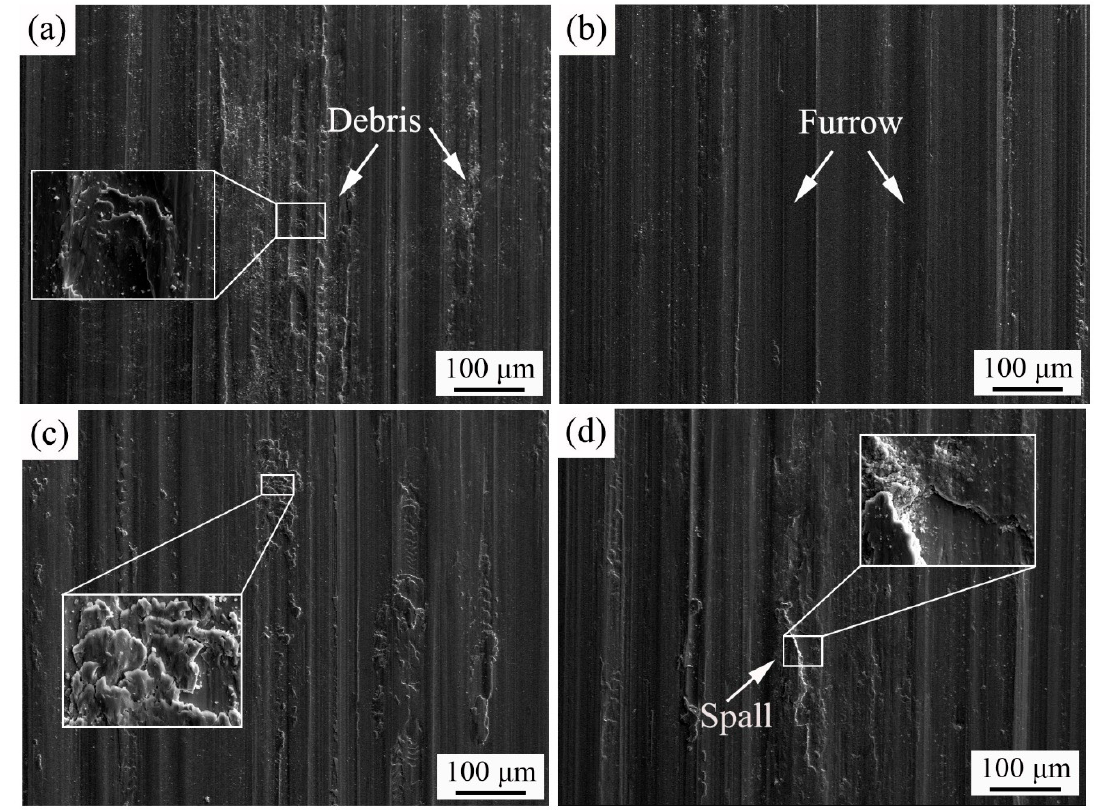
Figure 8. Wear of the modified layer with different laser scanning speeds. ( a ) Illustration of the wear contact mode of the ring-block; ( b ) Weight loss and wear depth after LSR.